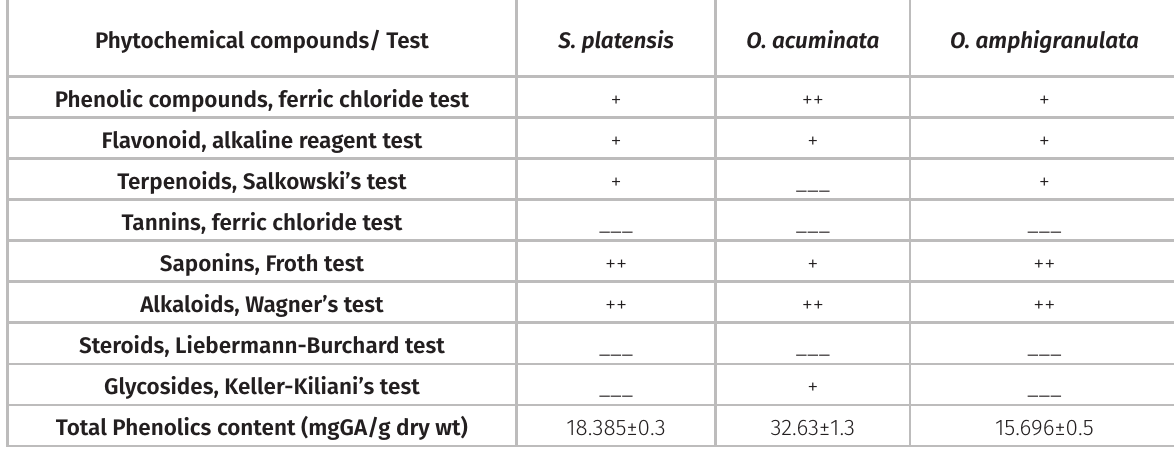
Table III. Qualitative phytochemicals screening of cyanobacterial species methanolic extracts. Phytochemical compounds/